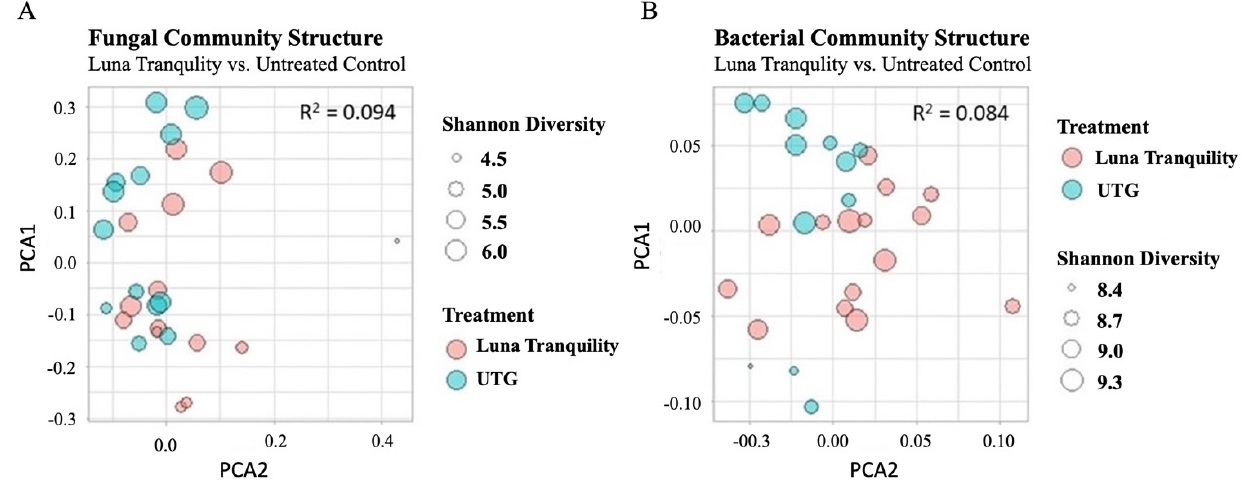
Figure 2. PCoA of community structures, Luna Tranquility and UTG. PCoA comparing Luna Tranquility (LT) and Untreated Control (UTG). ( A )—fungal; ( B )—bacterial populations. (ADONIS test, p < 0.05). See supplemental Figures S1 and S2 for other treatments.